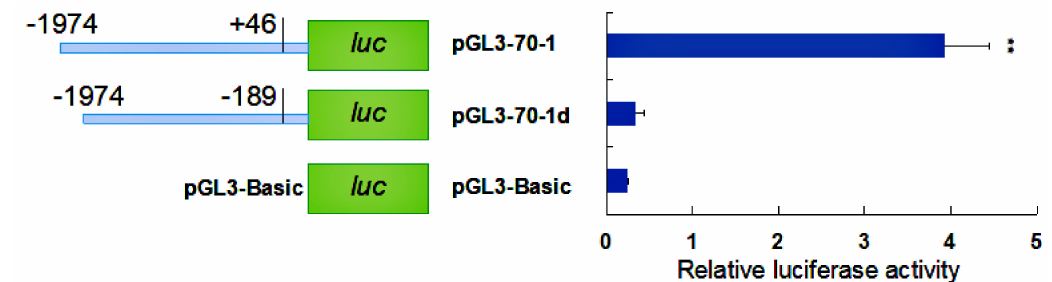
Figure 6. The relative activity of the HdHSP70 gene with and without the predicted core promoter region. The plasmid with one from − 1974 to +46 containing the core promoter region was named pGL3-70-1 and the other one from − 1974 to − 189 lacking the core promoter region was named pGL3-70-1d. Values are means ± SD of biological replicates ( n = 3). The significant difference is indicated by a (**) at p < 0.01 as compared with the control (pGL3-Basic). Luc: luciferase expression plasmids.